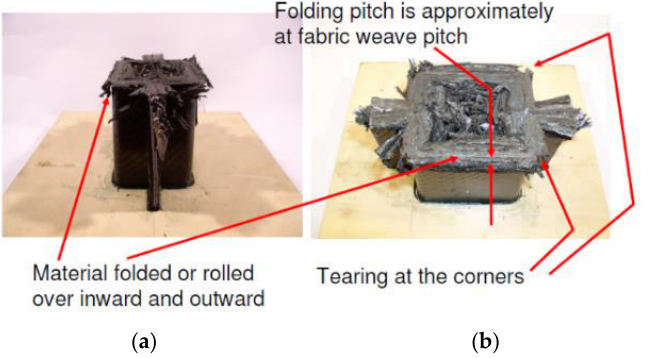
Figure 1. Progressive crushing destruction mode of FRP structure. ( a ) Perspective view; ( b ) enlarged view of the end.